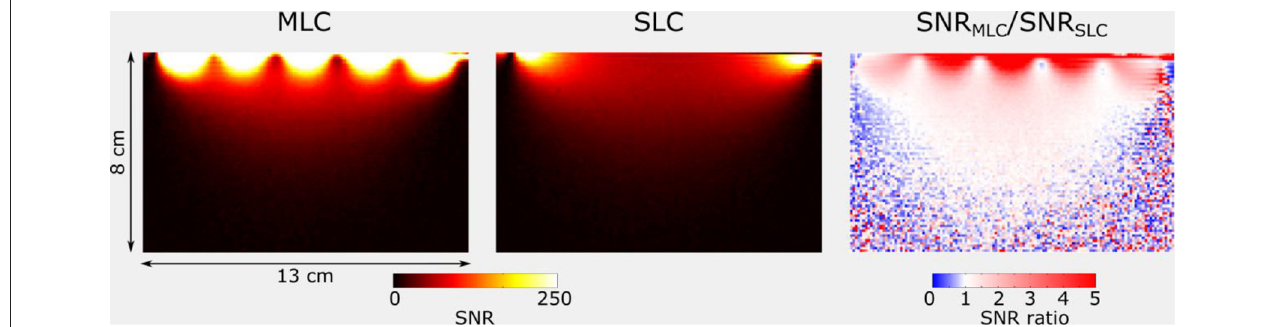
FIGURE 8 | SNR and ratio maps obtained for the central sagittal slice of 3D GRE acquisitions at 3T for MLC and SLC, respectively. Maps were cropped, so as to remove noise-only regions.